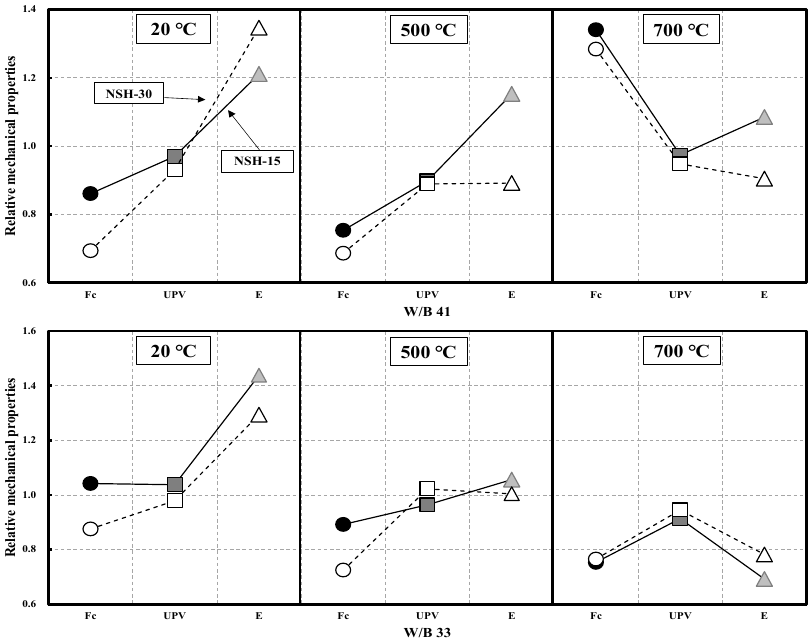
Figure 10. Relative mechanical properties according to replacement of NSH compared to NC by W/B.